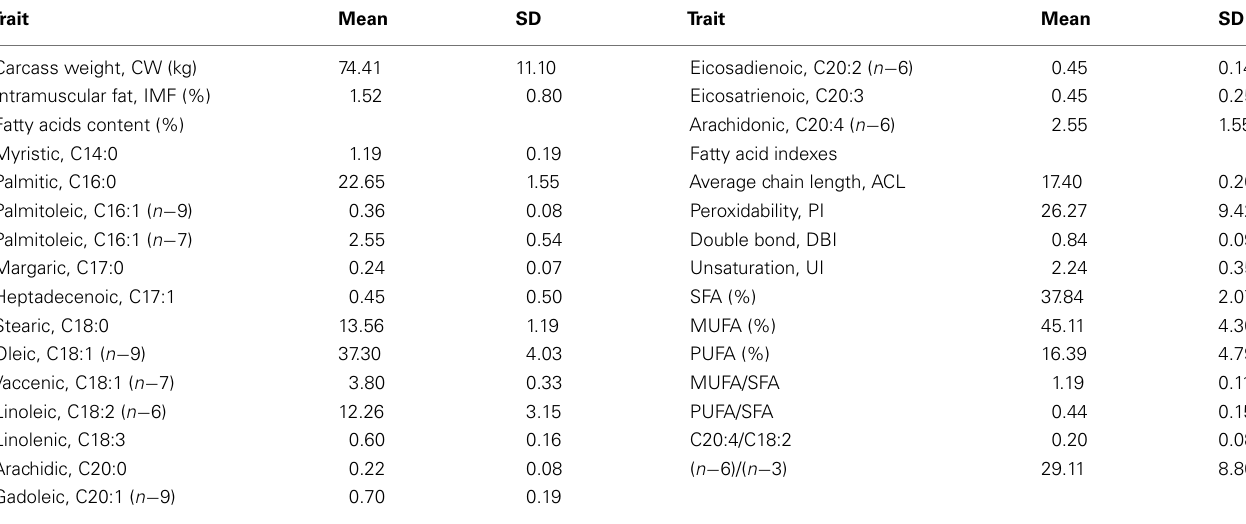
Table 1 | Phenotypic data analyzed in F3, BC1, and BC2 generations from Iberian × Landrace intercross (IBMAP).